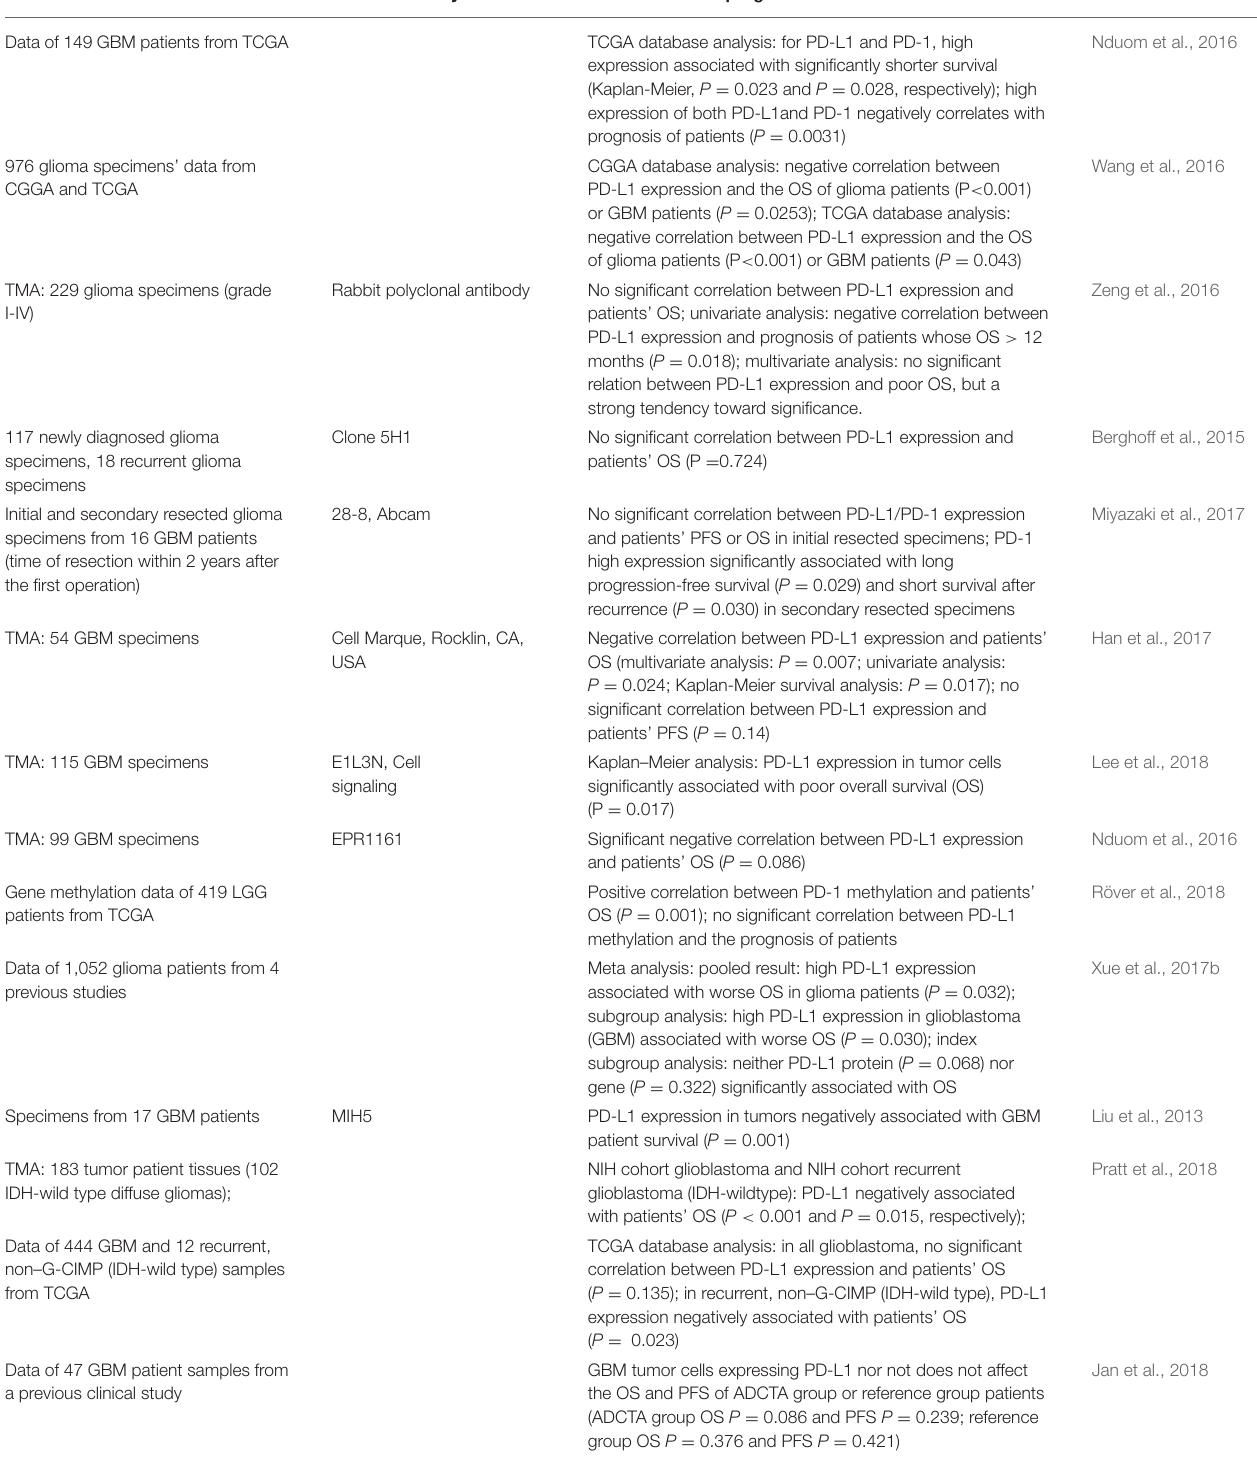
TABLE 2 | The relationship between PD-L1 expression and prognosis of glioma patients.